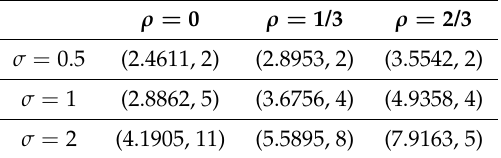
Table 2. Optimal rewards and optimal lengths of the short list with one DM based on 100,000 simulations (the first value in each cell gives the estimated optimal expected reward and the second the empirically derived optimal length of the short list). These results indicate that the length of the short list used by a single DM increases as the marginal value of the information from the second signal increases (i.e., as σ increases and ρ